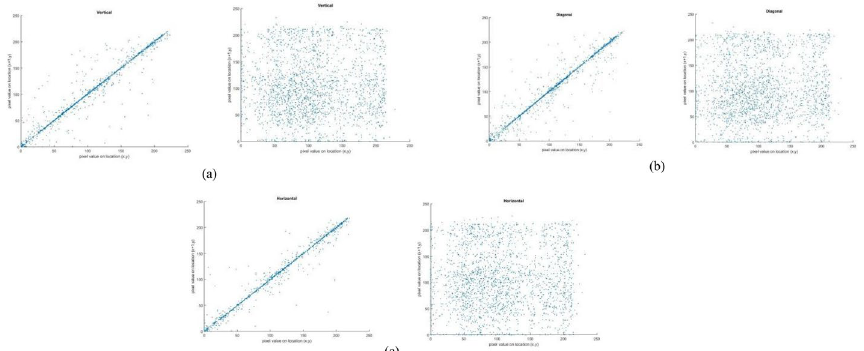
Fig. 7 a–c Correlation of adjacent pixels in (vertical, horizontal, diagonal) from plain & cipher